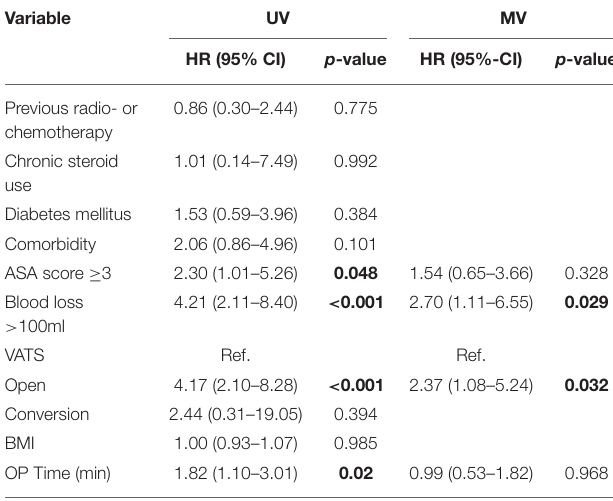
TABLE 3 | Analysis of factors associated with surgical site infection in 2,430 patients undergoing thoracic surgery.